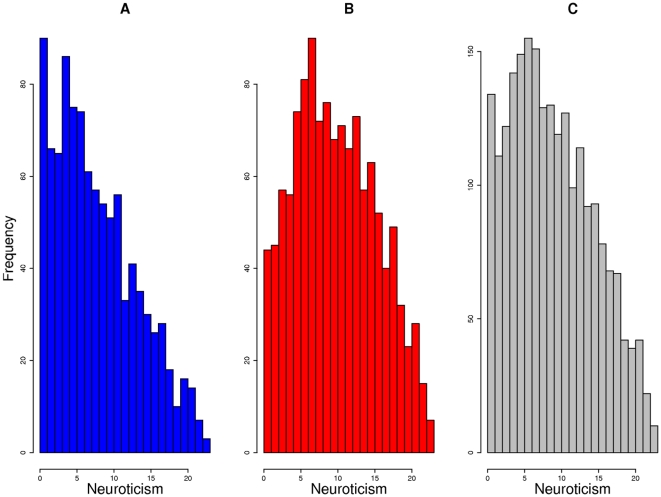
Distribution of EPQ-N score across the subjects.A: Males. B: Females. C: Both sexes.